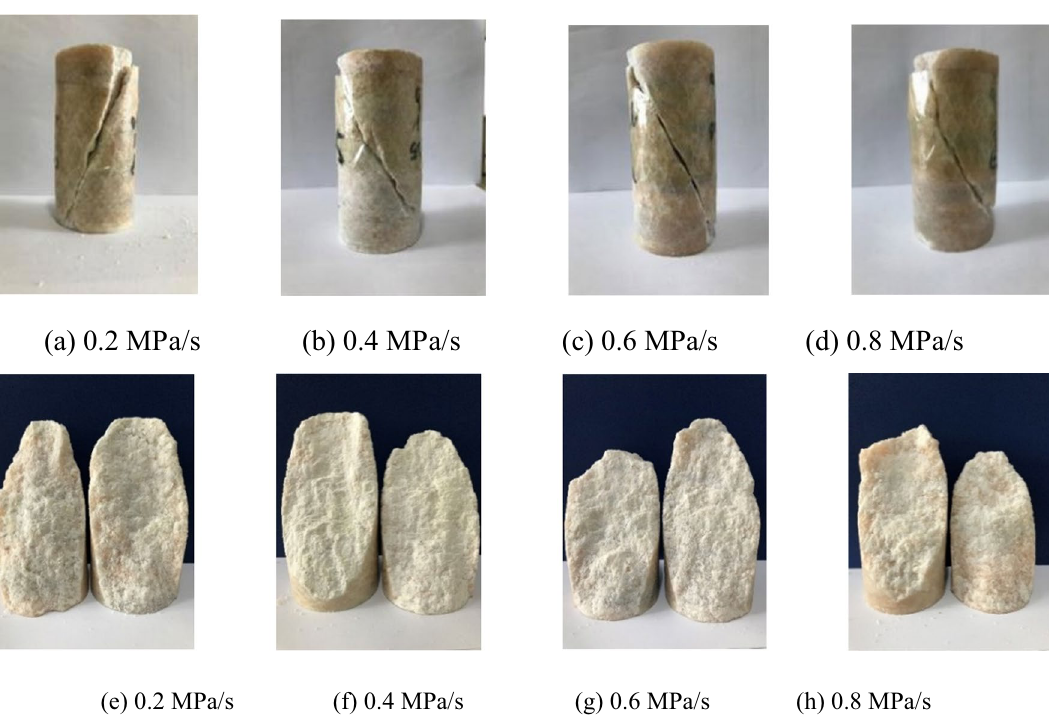
Figure 3. Failure modes and morphologies of failure planes of the marble during unloading of confining pressure at different